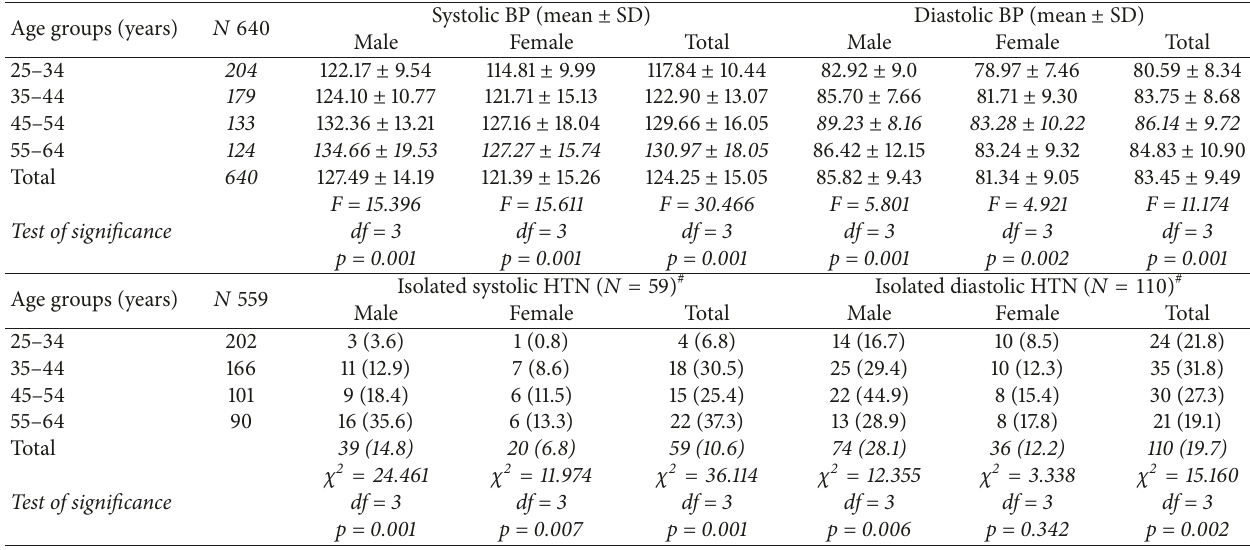
Table 3: Mean systolic and diastolic blood pressure (mmhg) and prevalence (%) of isolated systolic hypertensive and isolated diastolic hypertensive by age and gender.